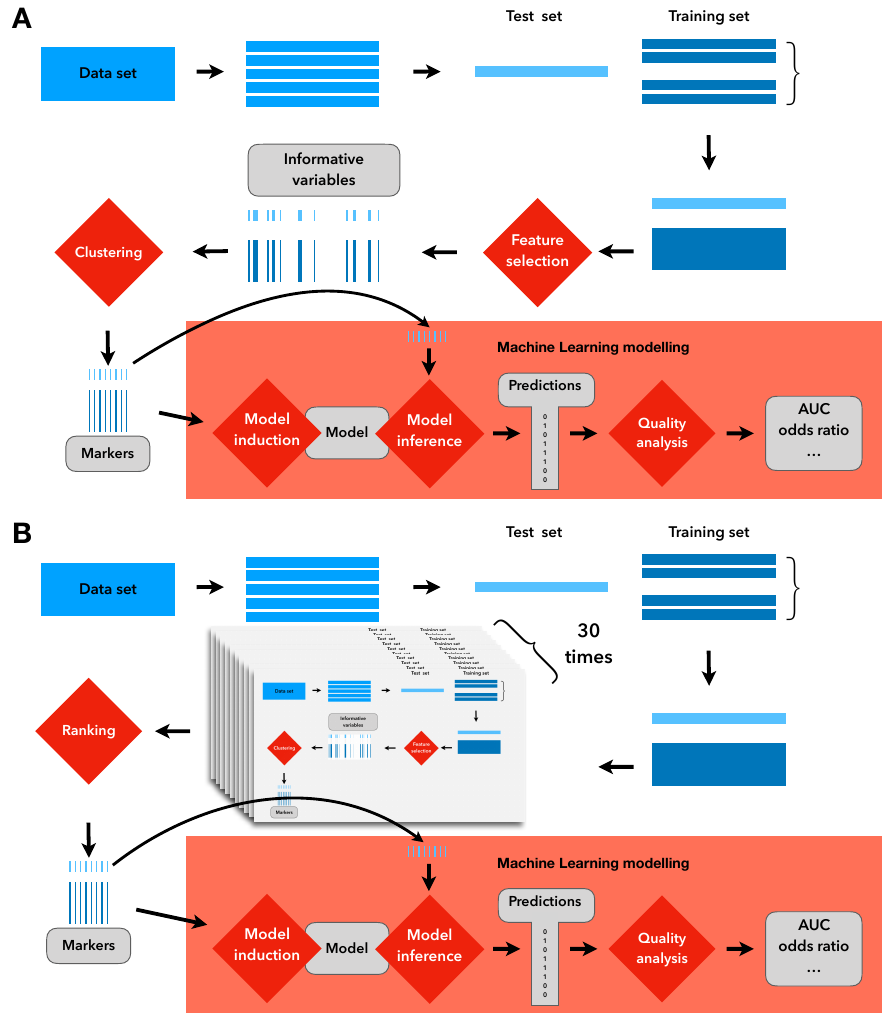
Figure 2. Depiction of a single run of the base protocol ( A ) and the proposed protocol ( B ). In ( A ), the clustering is used directly to obtain markers and build models on them. In ( B ), the ( A ) part is replicated, except for the highlighted part regarding model building and evaluation. Instead, the results of ( A ) are used to build a ranking of the most-commonly chosen variables, which then are used for model building and